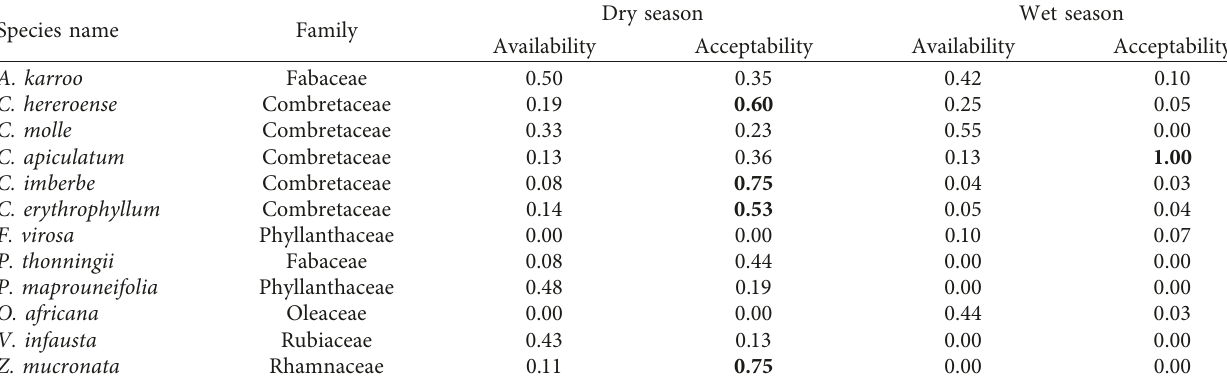
Table 3: Seasonal availability and accessibility of woody plant species browsed by giraffes in Umfurudzi Park. Species